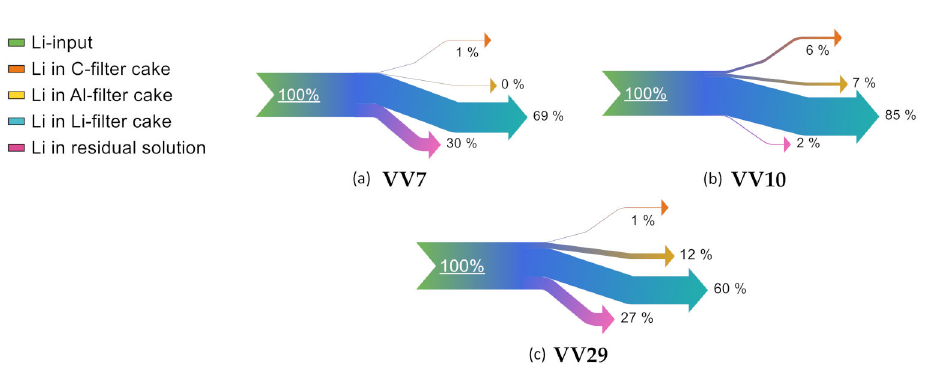
Figure 6. Sankey diagrams of the best HNO 3 trials for the target metal lithium. ( a ) 2-molar HNO 3 , solid / liquid ratio 1:100, leaching for 60 min at 23.15 ◦ C, pH-additive 8-molar NaOH, using of Al(OH) 3 nuclei and adding of Na 2 CO 3 ( b ) 4-molar HNO 3 , solid / liquid ratio 1:55, leaching for 60 min at 60 ◦ C, pH-additive 14-molar NaOH, using of Al(OH) 3 nuclei and adding of Na 2 CO 3 ( c ) 2-molar HNO 3 , solid / liquid ratio 1:50, leaching for 60 min at 60 ◦ C, pH-additive 8-molar KOH, using of Al(OH) 3 nuclei and adding of Na 2 CO 3 ( d ) 2-molar HNO 3 , solid / liquid ratio 1:50, leaching for 60 min at 60 ◦ C, pH-additive 2-molar KOH, using of Al(OH) 3 nuclei and adding of Na 2 CO 3.